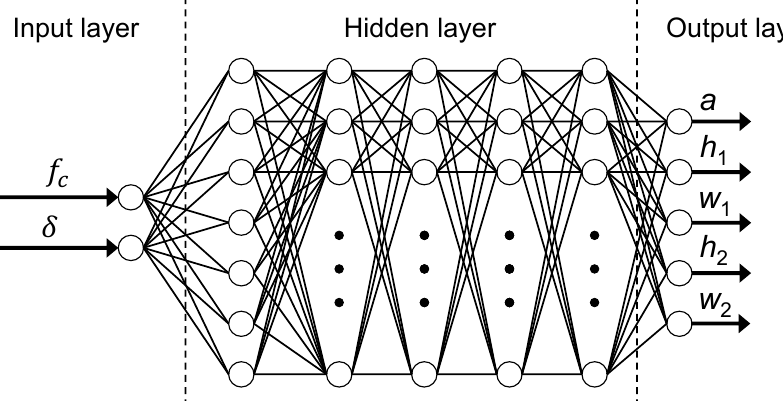
Figure 7. Diagram of the DNN architecture used in this